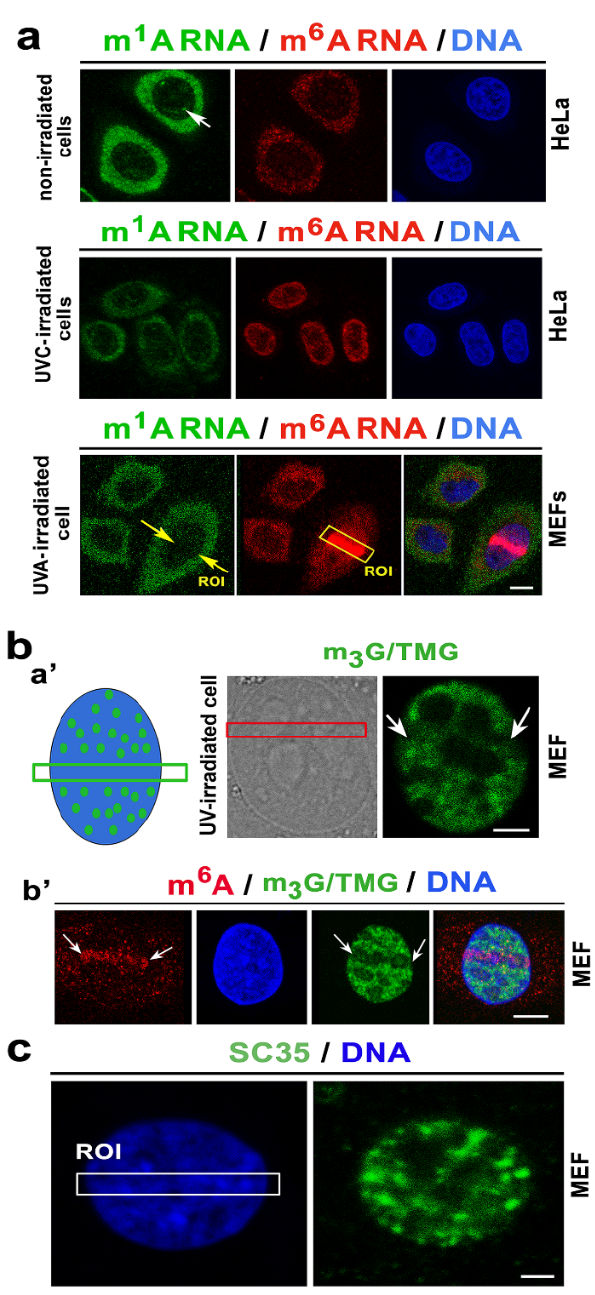
Figure 7. The level of m 1 A RNA is reduced by UV irradiation, and depletion of trimethylguanosine in RNAs (m3G / TMG) appears in the microirradiated chromatin. ( a ) Nuclear distribution pattern of m 1 A RNAs (green) and m 6 A RNAs (red) in nonirradiated cells; globally UVC-irradiated HeLa cells; and MEFs exposed to UVA-microirradiation. The irradiated region of interest is shown as a yellow frame or arrows, labeled as ROI. White arrow shows a tiny focus of m 1 A RNAs inside the cell nucleus. ( b ) The m 3 G / TMG level in ( a’ ) UVA-microirradiated MEFs (white arrows and red frame show microirradiated regions); ( b’ ) the level of m 6 A RNAs (red) and a reduced level of m 3 G / TMG (green) is shown in UVA-microirradiated MEFs (white arrows indicate the microirradiated genomic regions). ( c ) Local laser microirradiation did not a ff ect the nuclear distribution pattern or the level of splicing protein, SC35. Microirradiated ROI is shown by the white frame. DAPI (blue) was used for visualization of the cell nuclei. Scale bars in panel a represent 10 µ m; in panel ba’ , they represent 5 µ m; in panel bb’ , they represent 10 µ m; and in panel c , they represent 5 µ